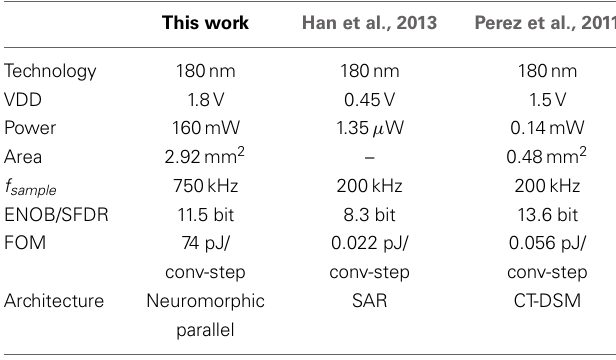
Table 8 | Medium sample rate, medium resolution comparison.